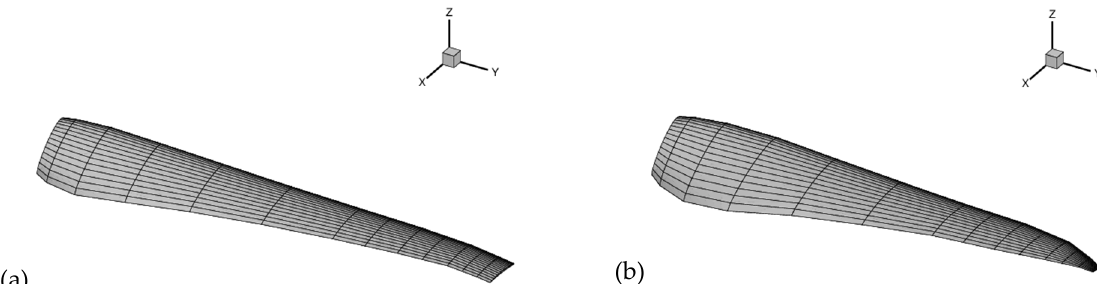
Figure 9. Rotor blades’ discretized geometry. Tip propeller ( a ); DEP propellers ( b ).